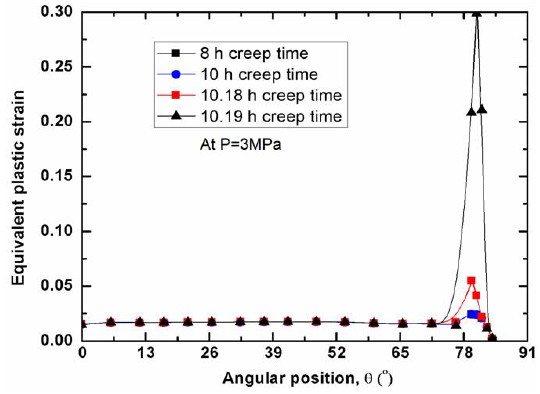
Figure 11. Effect of creep on plastic strain distribution for RPV with high water level.